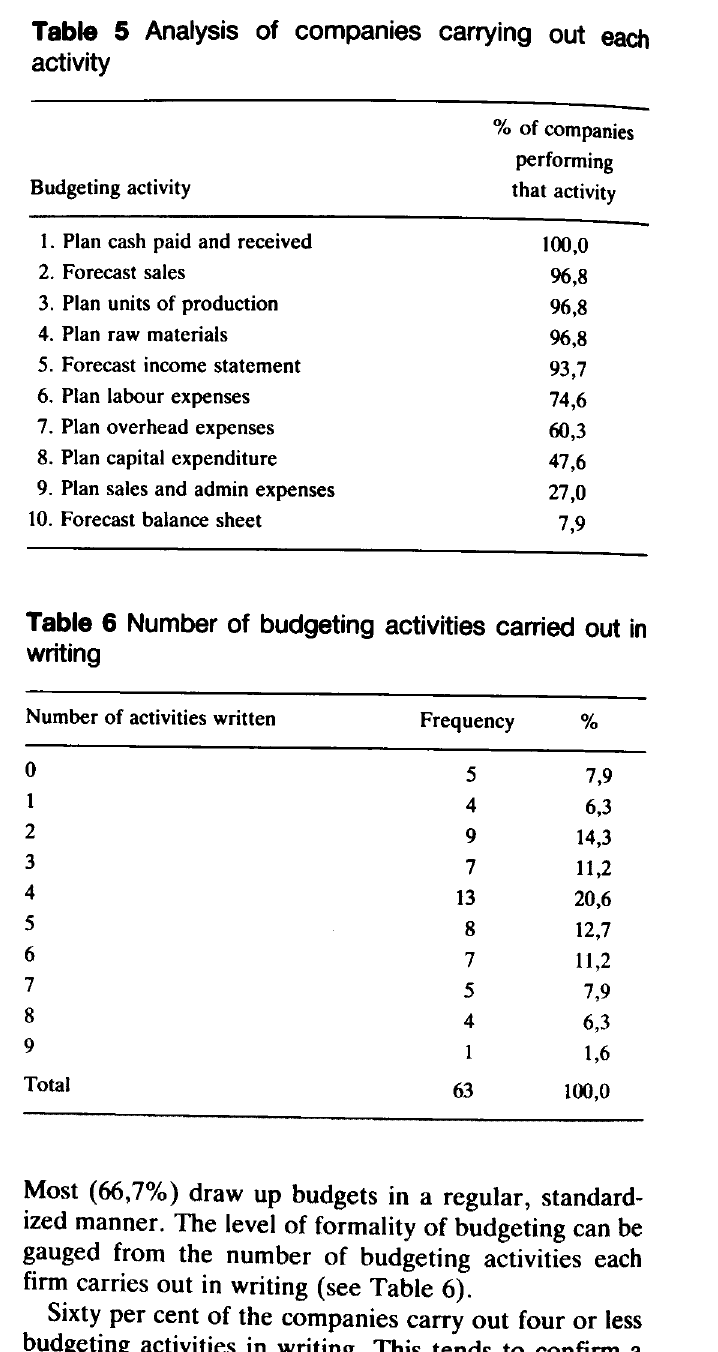
Table 4 Budgeting activities effected by each company Number of budgeting